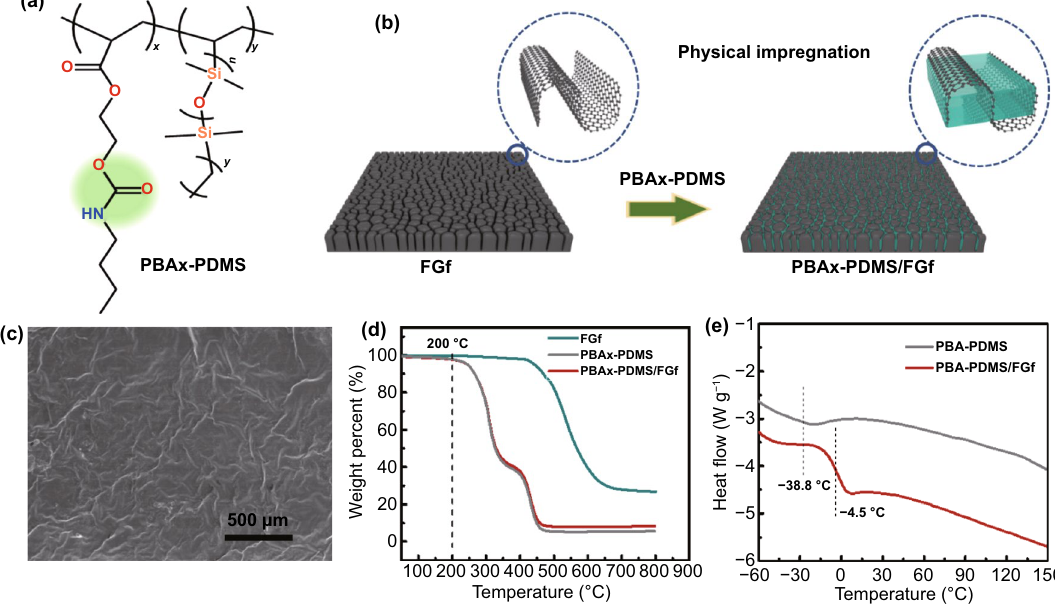
Fig. 1 a Chemical structure of PBAx–PDMS. b Process of preparing PBAx–PDMS/FGf. c SEM images of PBAx–PDMS/FGf. d Thermogravi- metric analysis (TGA) plots of PBAx–PDMS, FGf, and PBAx–PDMS/FGf. e Differential scanning calorimetry (DSC) curves of PBA–PDMS and